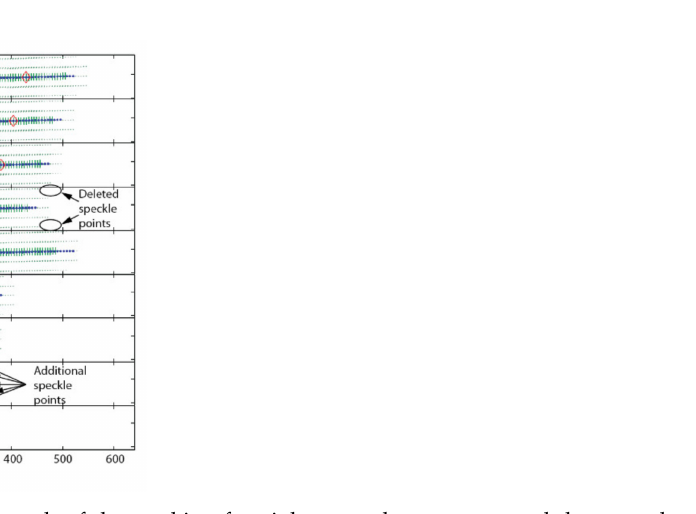
Figure 25. On the left: result of the tracking for eight secondary sweeps and the central sweep, including additional speckle points for the top point of view of the right eye of the ASP. The secondary sweeps are plotted one above the other to reveal the details. In practice, they all overlap the central sweep. Right: magnification of the extremity of a secondary sweep showing missing speckle points dropped from the calibration data because the correlation coefficient was too small (the tracked speckle points were near the border of the circle).